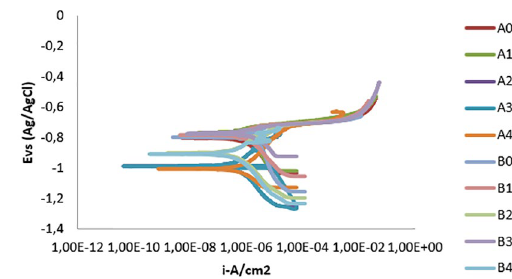
Figure 1. Polarization curves of unreinforced and reinforced ZA-27 alloy composites in 3.5 wt% NaCl